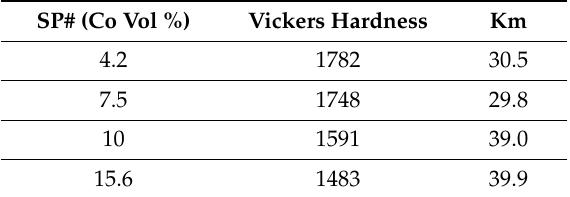
Table 2. Data from Seikh et al. [9] on Co Vol %; Vickers hardness and